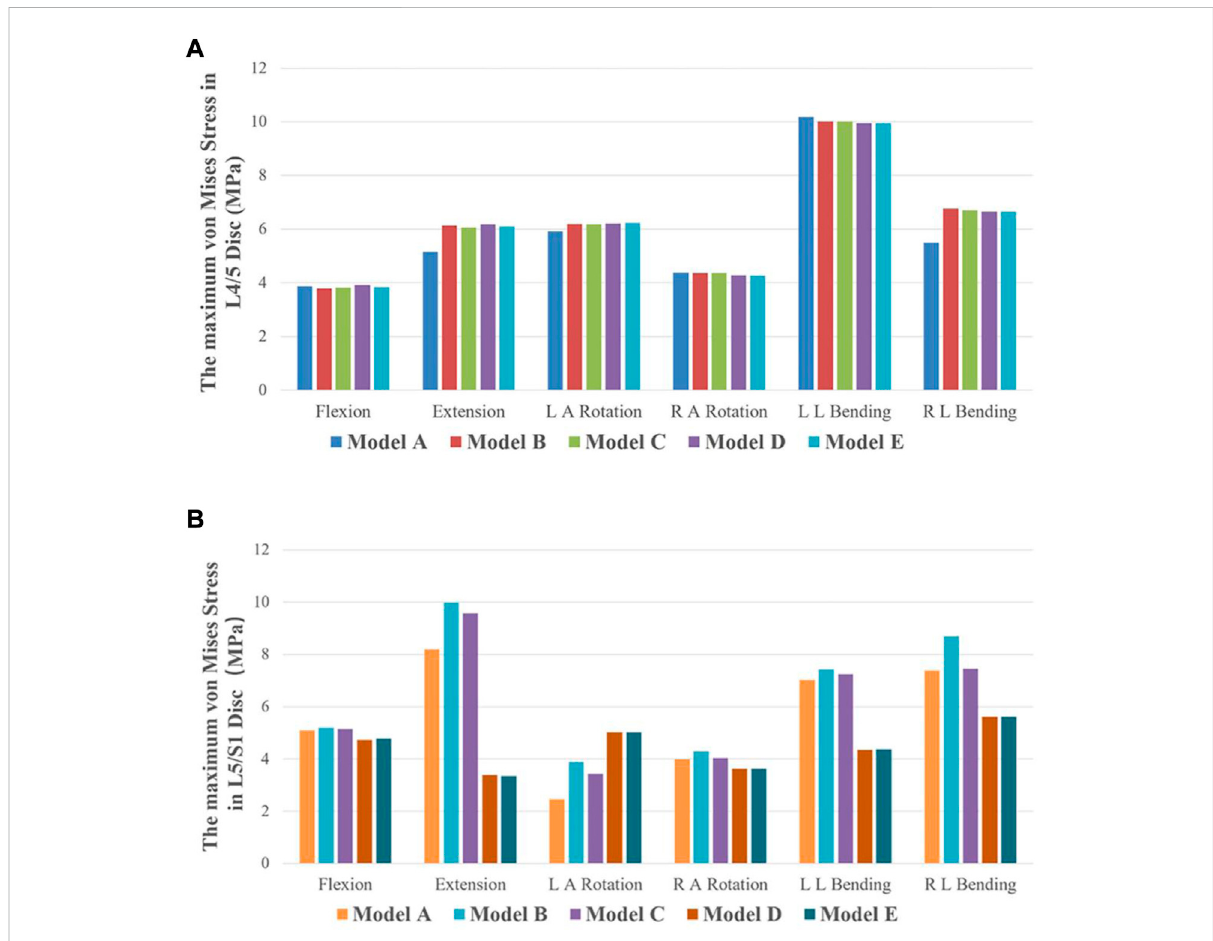
FIGURE 6 The maximum von Mises stress of discs in fi ve fi nite element models under six motion states. (A) The maximumvon Mises stress of L4/L5 IVD in the fi ve models. (B) The maximum von Mises stress of L5/S1 IVD in the fi ve